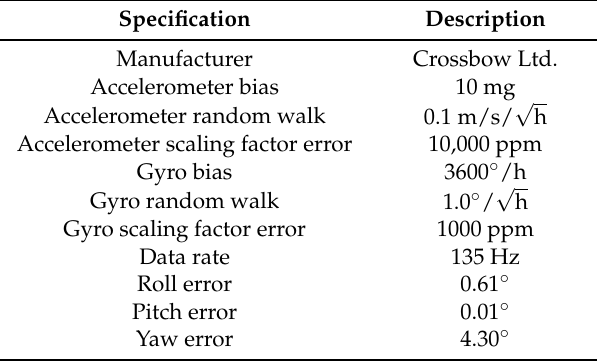
Table 4. IMU specification and initial attitude error for the experiment.